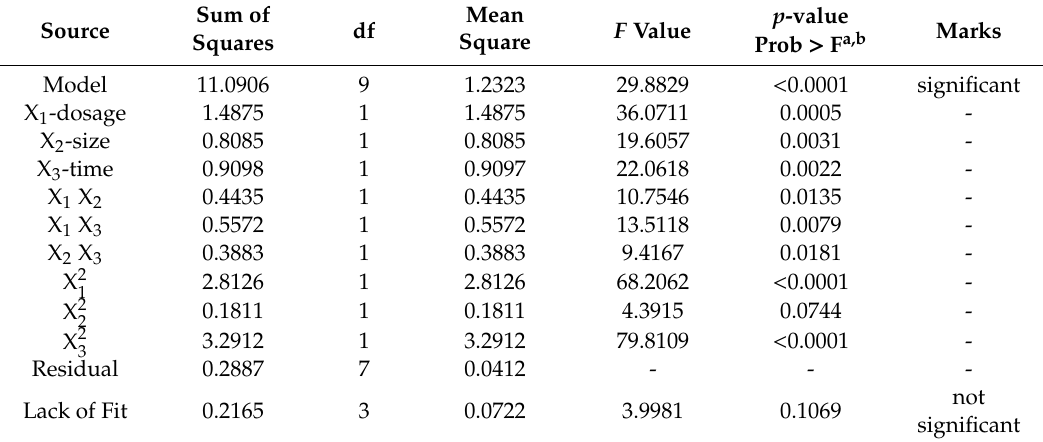
Table 5. Analysis of variance (ANOVA) for the regression